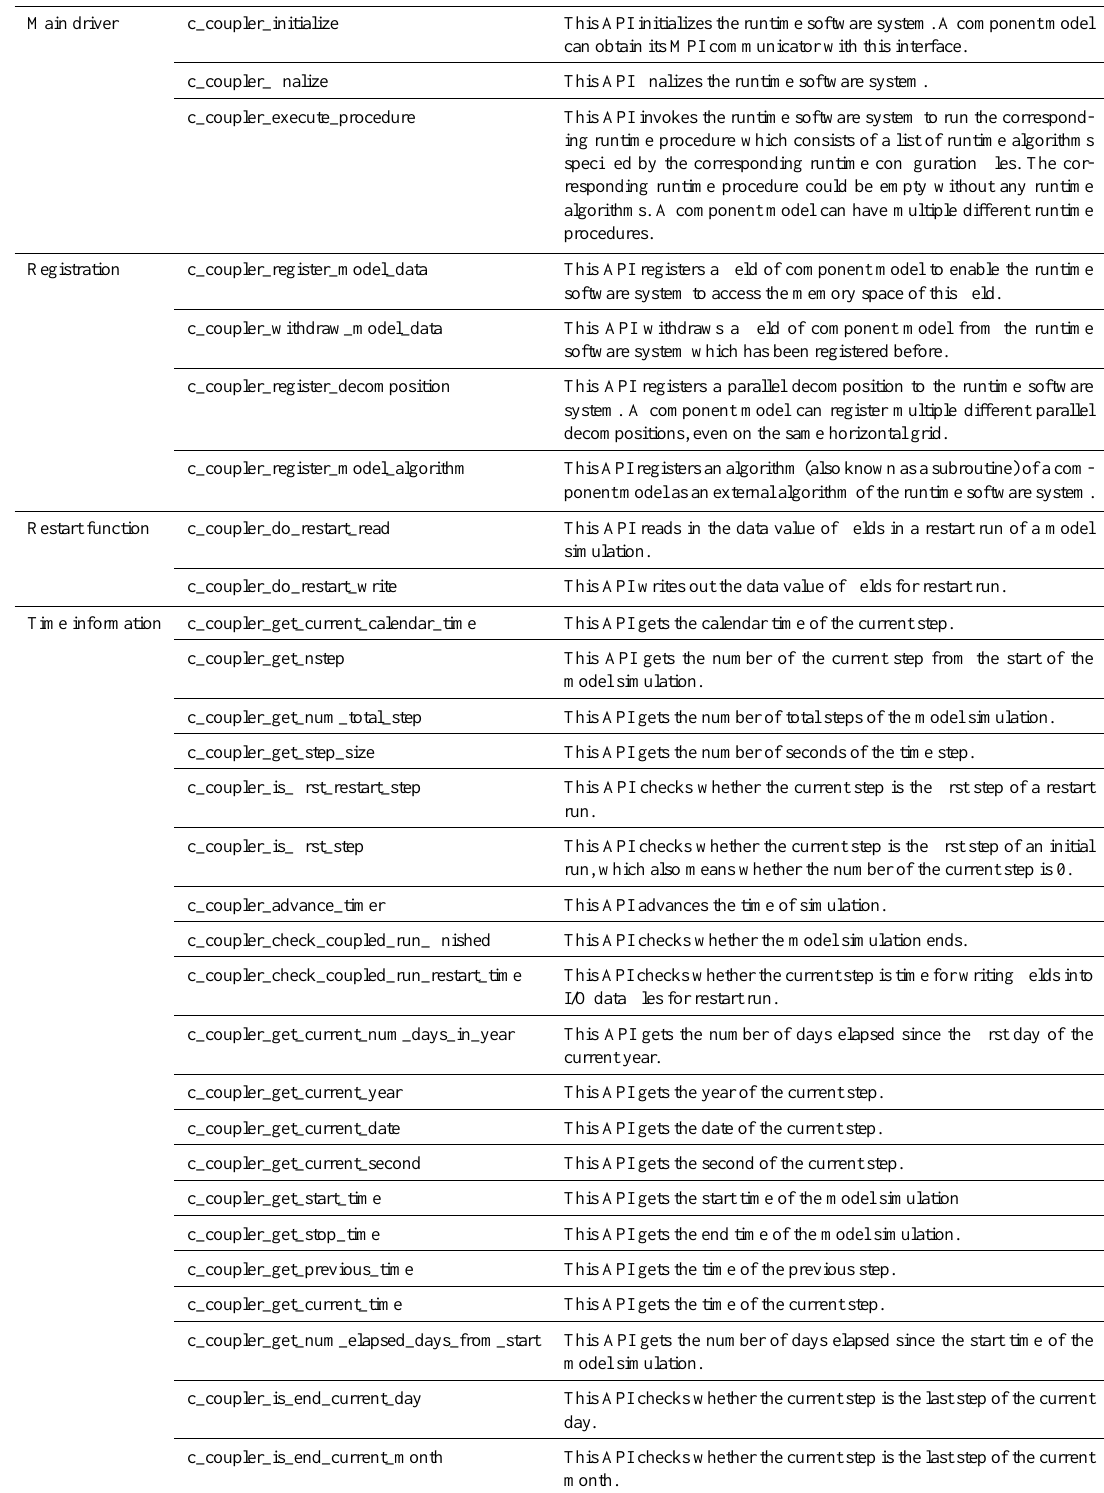
Table 1. The APIs provided by C-Coupler1. Classification Brief